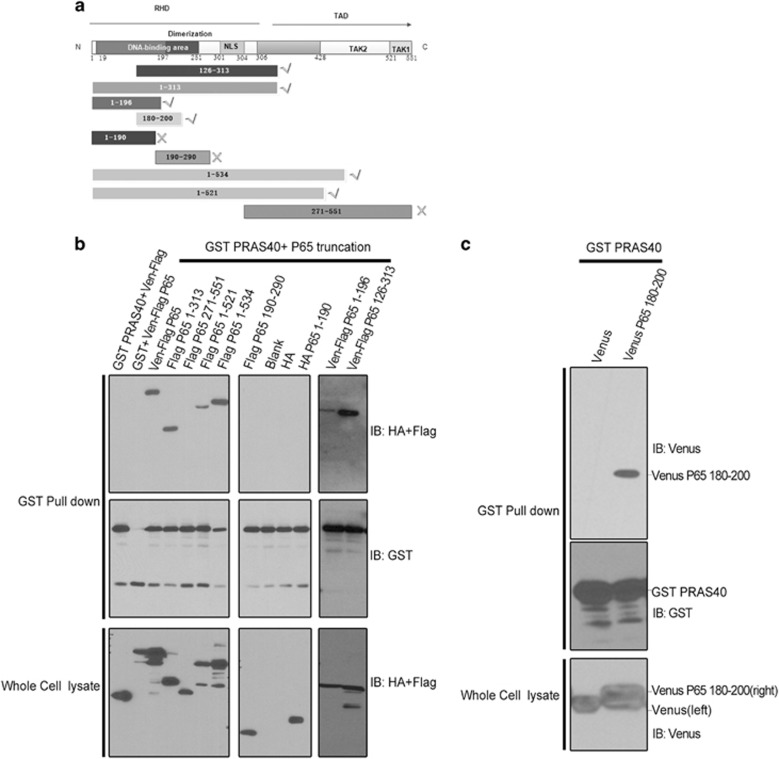
Residues 180-200 of p65 are sufficient for PRAS40 association. (a) Truncations of P65 were made based on its known structure and function. RHD represents Rel Homology Domain for the function of dimerization and TAD means transcription activation domain. ✓ means could interact with PRAS40; × means could not interact with PRAS40 according to the results of a GST co-precipitation assay (b, c). (b) Left blot: Full-length and truncations of P65 (1-313, 1-521, 1-534) could be co-precipitated by PRAS40. Middle blot: p65 truncations 190-290 and 1-190 of P65 could not be co-precipitated by PRAS40. Right blot: p65 truncations 1-196 and 126-313 could be co-precipitated by PRAS40. The remaining lanes were the negative controls. (c) A Venus-tagged p65 180–200 peptide could be co-precipitated by PRAS40.